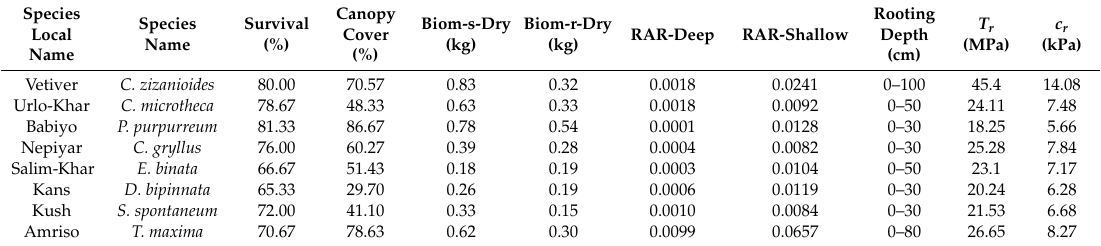
Table 3. Summary of KPIs of the model plant (grass) species (mean values from the three sites). Species